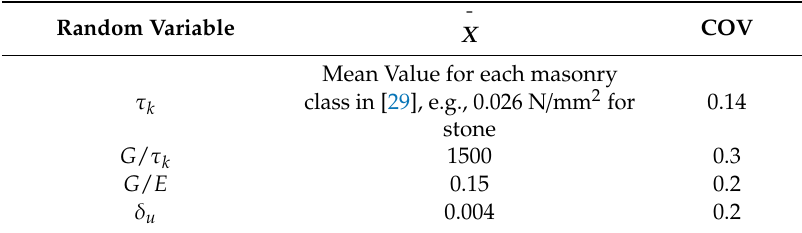
Table 1. Statistical description of uncertain